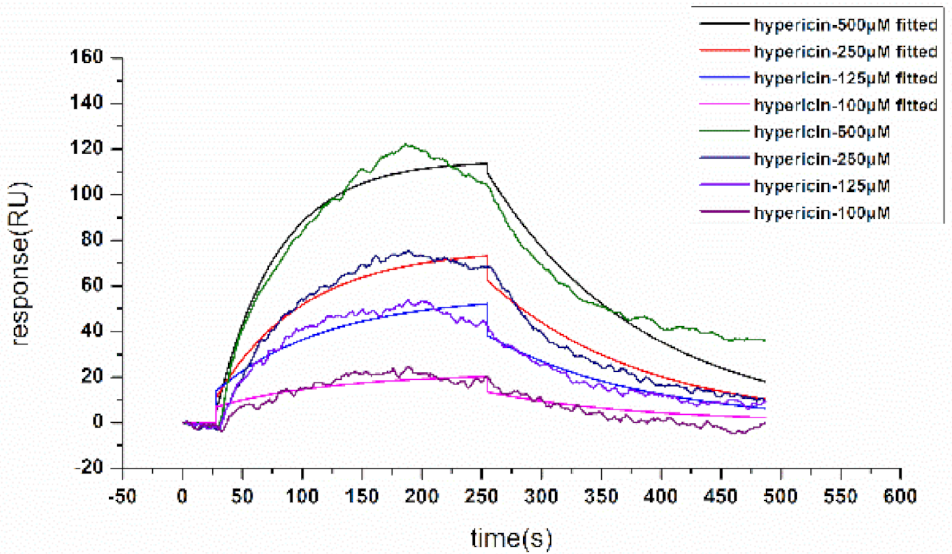
Figure 2. Surface plasmon resonance (SPR) concentration-signal